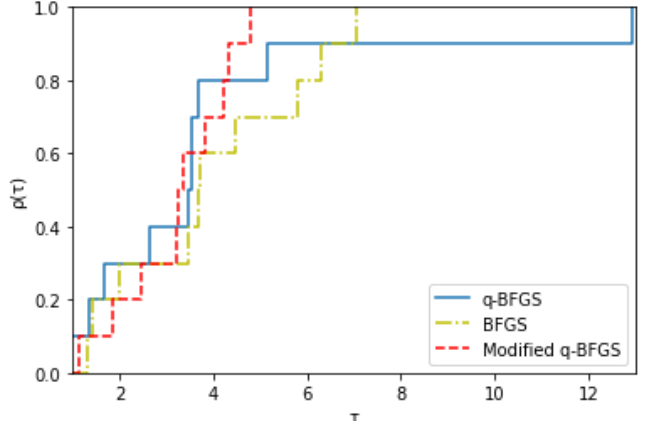
Figure 3. Performance profile based on number of gradient